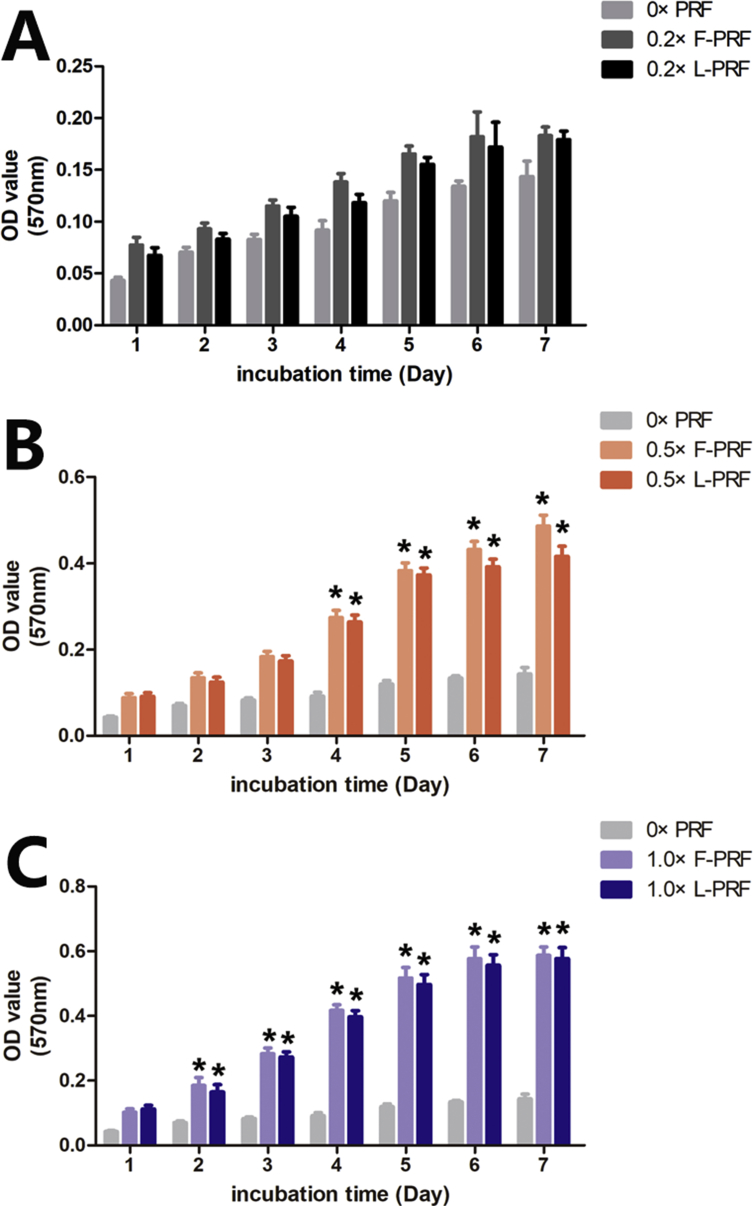
The effects of L-PRF on the proliferation capacity of BMSCs. MTT assays were performed to examine the effects of L-PRF on the proliferation of BMSCs. The proliferative ability of BMSCs significantly improved by increasing the L-PRF or F-PRF concentrations from 0.2× PRF to 1× PRF in the culture medium. (A–C) Enhanced cell proliferation was observed in the 0.5× and 1× PRF groups compared with that observed in the control and 0.2× PRF groups on the fourth day of cultivation (P = 0.01). Moreover, enhanced cell proliferation was observed in the 1× PRF groups compared with the 0.5× PRF groups starting on the third day of cultivation (P = 0.01). However, a significant difference between the F-PRF and L-PRF groups at the same time point was not observed (P > 0.05). These results showed that L-PRF had a significant, dose-dependent and durable biological stimulative effect on the proliferative capacity of BMSCs in vitro. * Indicates a significant difference compared to the control group (P < 0.05).